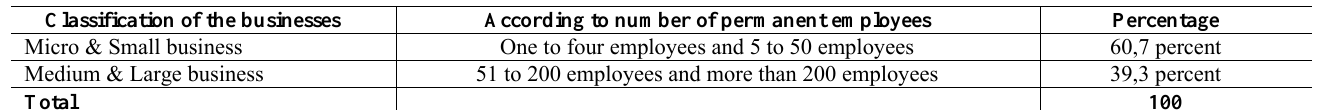
Table 3: Classifications of responding businesses according to the white paper Classification of the businesses According to number of permanent